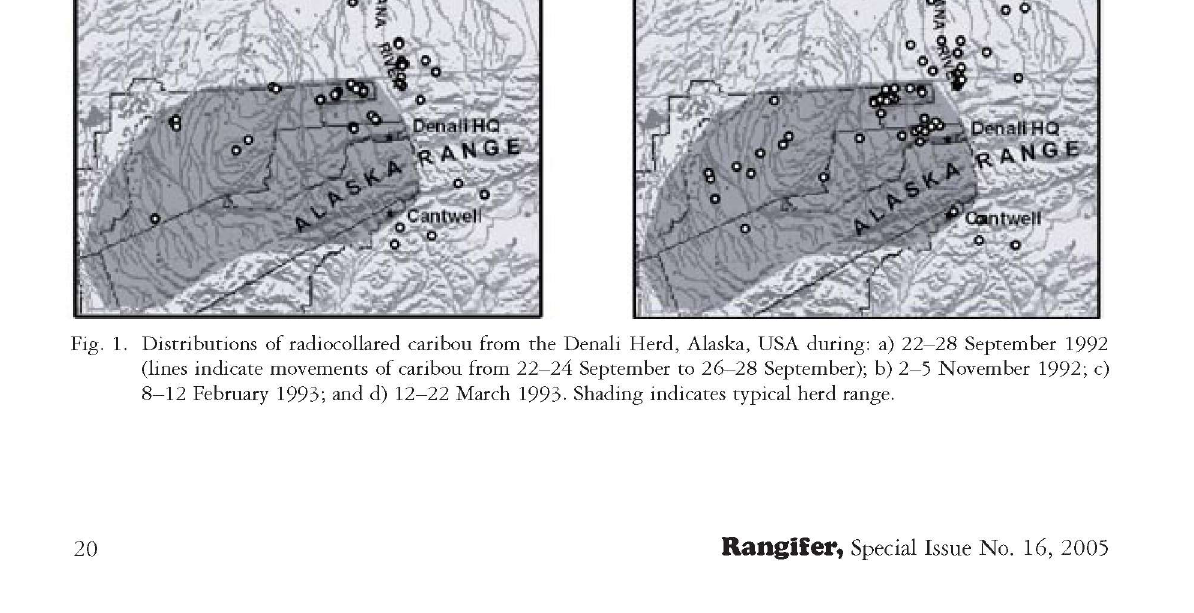
Rangifer, Special Issue No. 16,